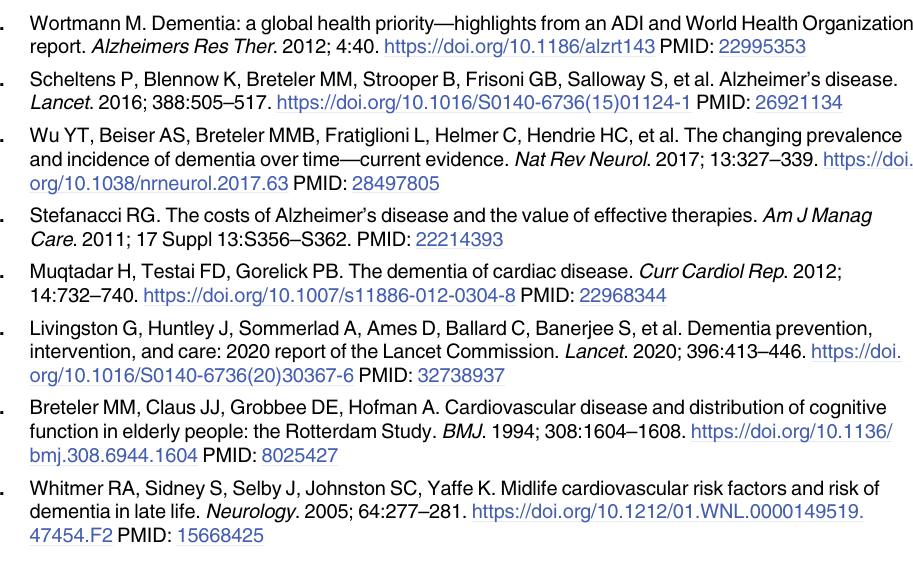
S3 Table. The comparison of the impact on the dementia and its subtypes after excluding other cardiac